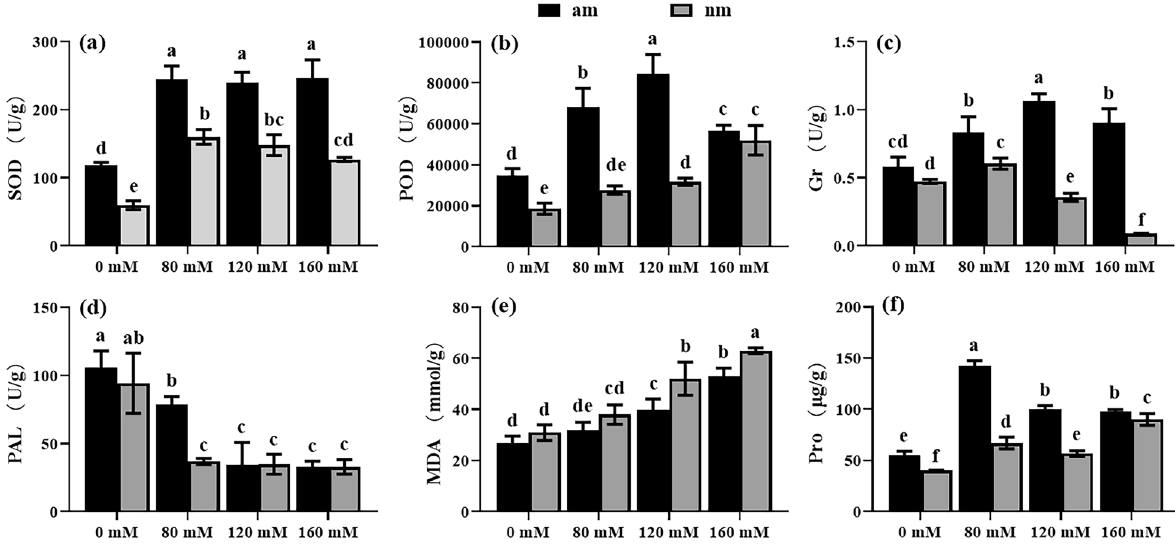
Fig. 4 MDA contents, osmotic regulatory substances, and antioxidant enzyme activities in rice leaves. Note: a SOD; b POD; c Gr; d PAL; e MDA; f Pro. The results were the mean standard deviation of three replicates. Different letters indicate the difference between different treatment groups. ± ( P <